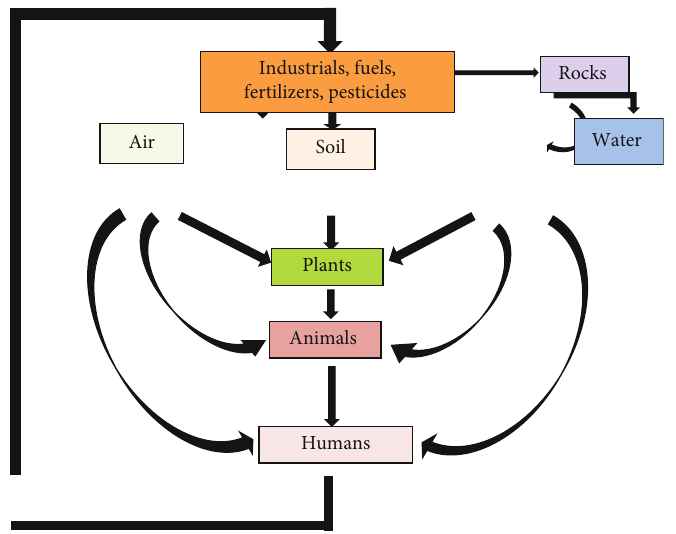
Figure 1: Sources and cycles of heavy metals in the environment